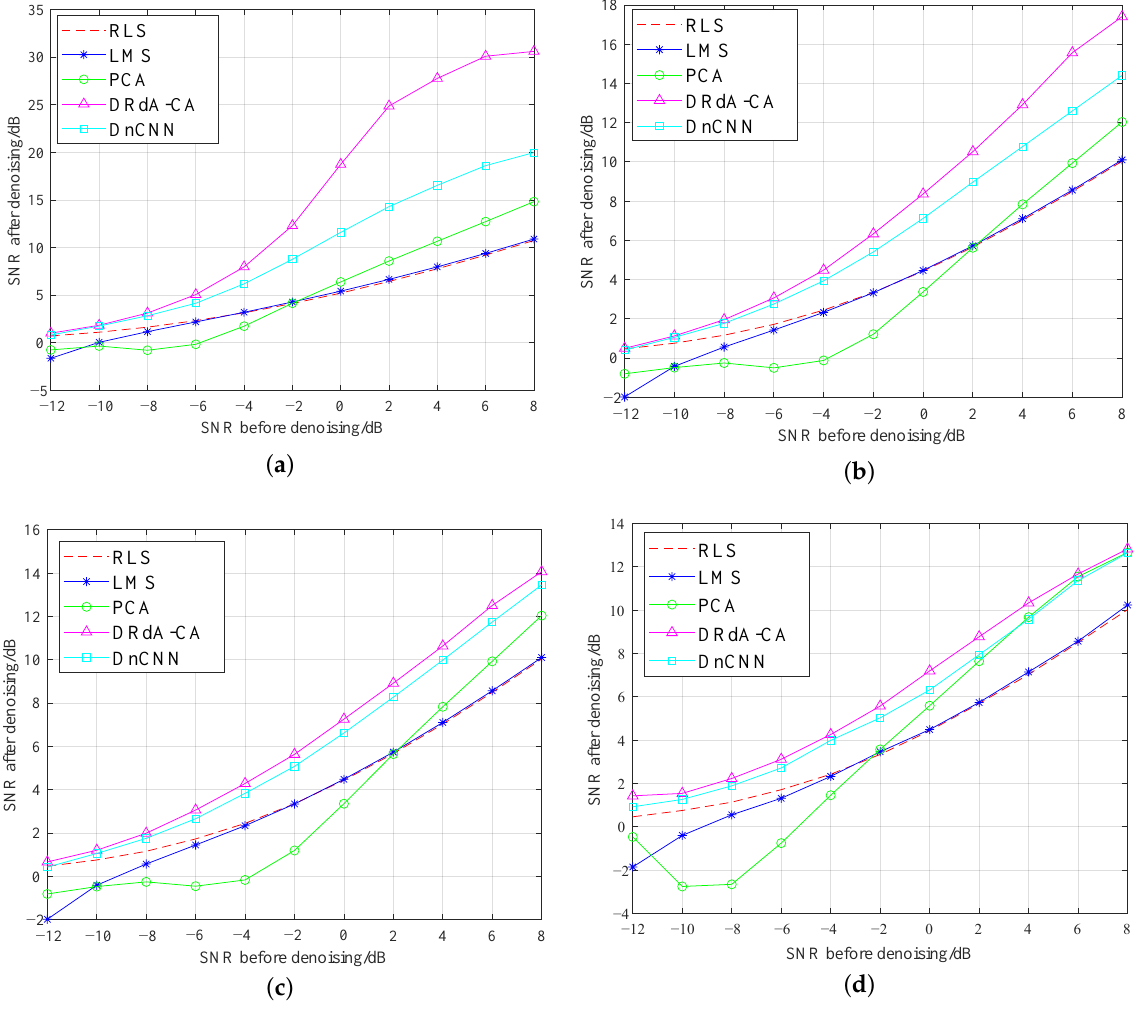
Figure 7. SNR of modulation signal after denoising [2,3,5–7,18]. ( a ) GMSK. ( b ) 8PSK. ( c ) 16QAM. ( d )